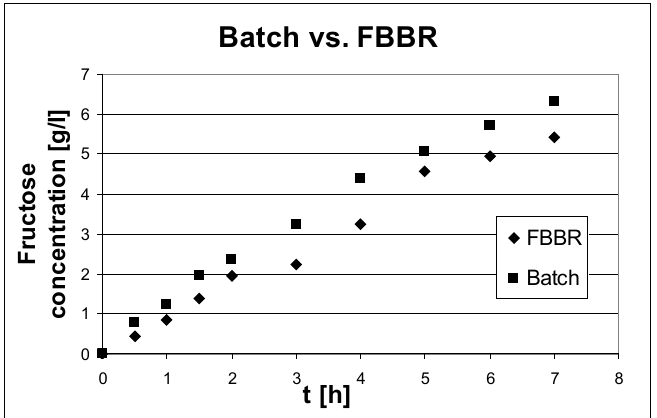
Figure 5. Continuous versus discontinuous reactor Batch vs.